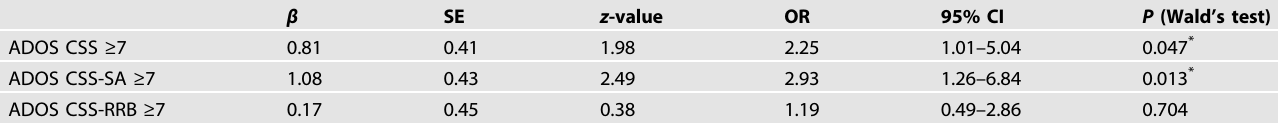
Table 2. Generalised linear models evaluating the presence of at least one atopic condition as a predictor of moderately high to severe ASD-related symptomatology in children. β SE z -value OR 95% CI P (Wald ’ s test) ADOS CSS ≥ 7